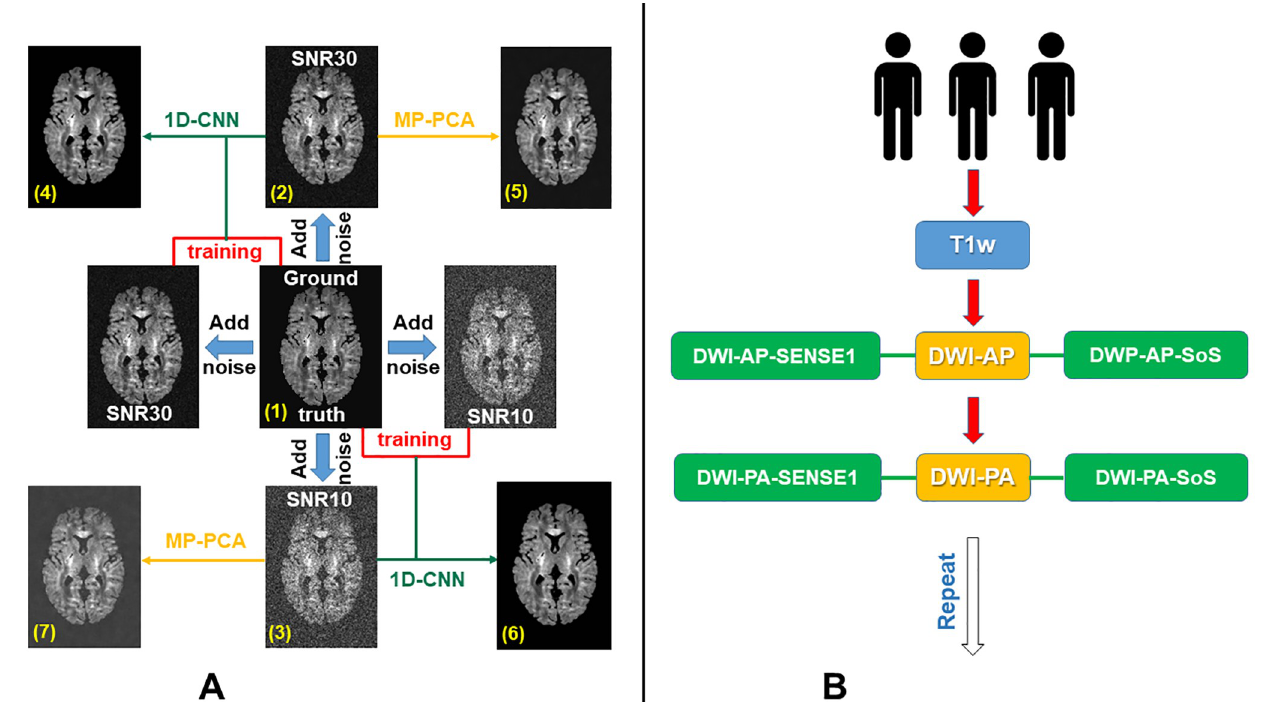
Fig 2. A. We simulated a noise-free ground truth dataset (1) and added noise to create a low-noise dataset with SNR 30 (2) and a high-noise dataset with SNR 10 (3) to evaluate 1D-CNN denoising. The low-noise and high-noise simulated datasets were both denoised using 1D-CNN and MP-PCA, resulting in four additional datasets: low-noise after 1D-CNN denoising (4), low-noise after MP-PCA denoising (5), high-noise after 1D-CNN denoising (6), and high-noise after MP-PCA denoising (7). B. Denoising SoS-related noise using SENSE1 reference data. MRI scans were acquired from 3 subjects for denoising validation. There are two identical runs, each consisting of one T1w scan, two DWI scans with opposite phase encoding directions (DWI-AP and DWI-PA). Each DWI scan is constructed with SoS and SENSE1 coil combines, respectively to generate two sets of images. simulated based on the DW-POSSUM framework [41], with 4 volumes at b-value = 0 s/mm 2 (b0), 90 diffusion directions at b-value = 1000 s/mm 2 (b1000) and 90 diffusion directions at b- value = 2000 s/mm 2 (b2000). To generate the low-noise and high-noise DWI datasets, Gauss- ian noise was added to the real and imaginary channels of the noise-free ground truth using an eight-channel coil model followed by adaptive coil combine. For simplicity, we did not intro- duce motion, eddy current distortion, or physiological noise into the simulated datasets. Data processing : 1D-CNN . We performed two training procedures, one for the simulated low-noise DWI data and the other for the simulated high-noise DWI data, so that the image pairs used for training the 1D-CNN models were: (1) low-noise DWI data and the noise-free ground truth and (2) high-noise DWI data and the noise-free ground truth. Both 1D-CNN models were trained with the following training parameters: 20000 epochs, learning rate of 0.001, and batch size of 6000. The model trained with the low-noise dataset was applied to the held-out low-noise DWI dataset that was simulated for testing. The model trained with the high-noise DWI dataset was applied to the held-out high-noise DWI dataset that was simu- lated for model testing. Data processing : MP-PCA . MP-PCA denoising was applied to the simulated low-noise and high-noise DWI data using the “dwidenoise” command in MrTrix3 (https://www.mrtrix.org/ ). All options were default except for “extent”, whose default setting was changed to 9 × 9 × 3 from 9x9x9 to account for our simulated data including only 4 slices.